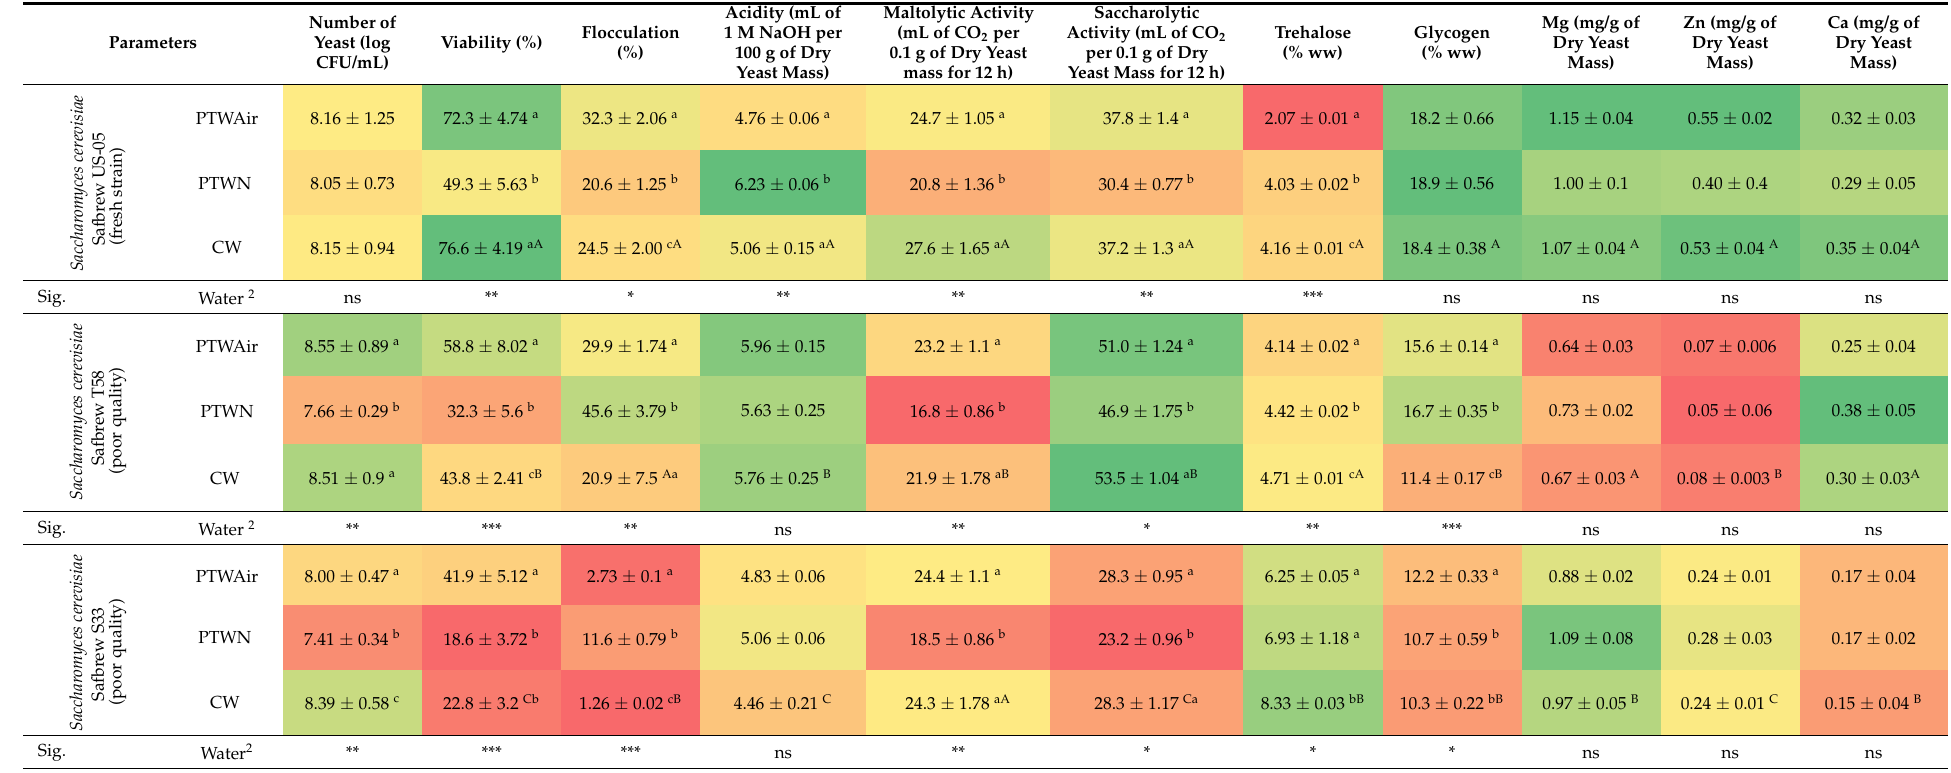
Table 2. Qualitative characteristics of the Saccharomyces cerevisiae (Safbrew T58, US-05, S33) and Saccharomyces pastorianus (SafLager W30/70) yeast strain after rehydration with plasma-treated water (PTWAir, PTWN) and control water